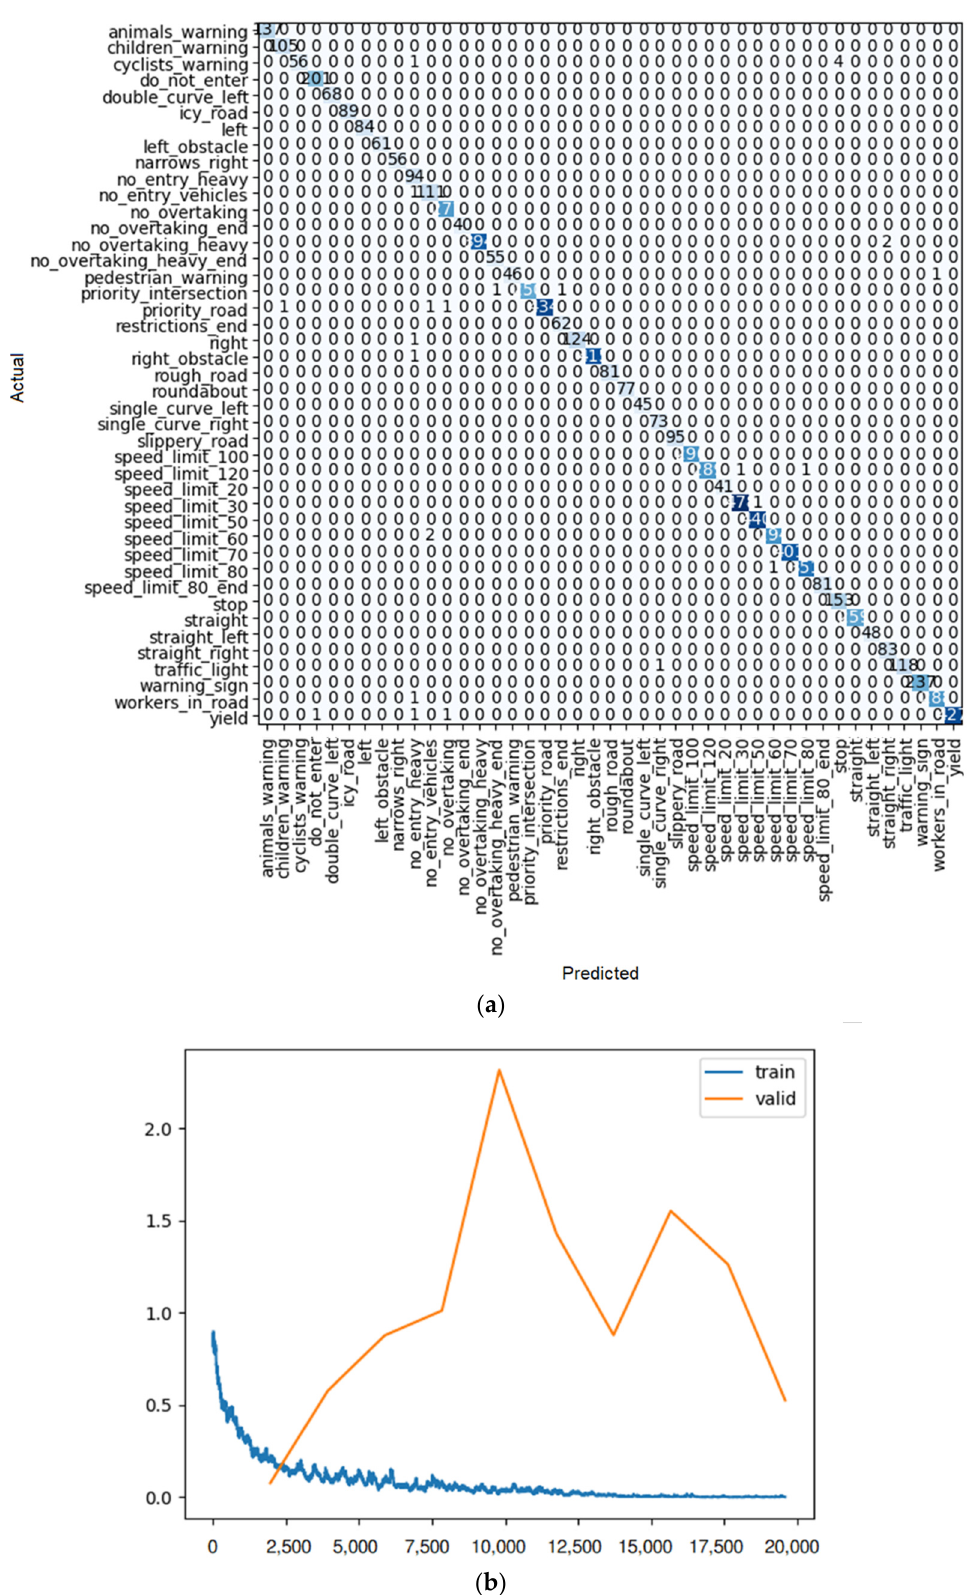
Figure 13. ( a ) Confusion matrix and ( b ) loss rate during training with SqueezeNet1_0.